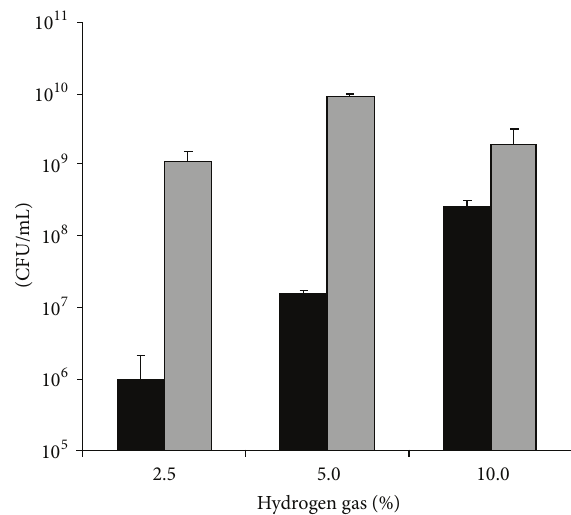
Figure 1: Growth of C. concisus P3UCO-S1 strain under various hydrogen gas concentrations. CFU of C. concisus was measured after incubation under microaerobic (black bar) or anaerobic (grey bar) condition with different hydrogen gas concentrations for 48 hours. The experiment was repeated twice. The error bar indicates the standard deviation. P3UCO-S1 strain is an oral strain isolated from a patient with